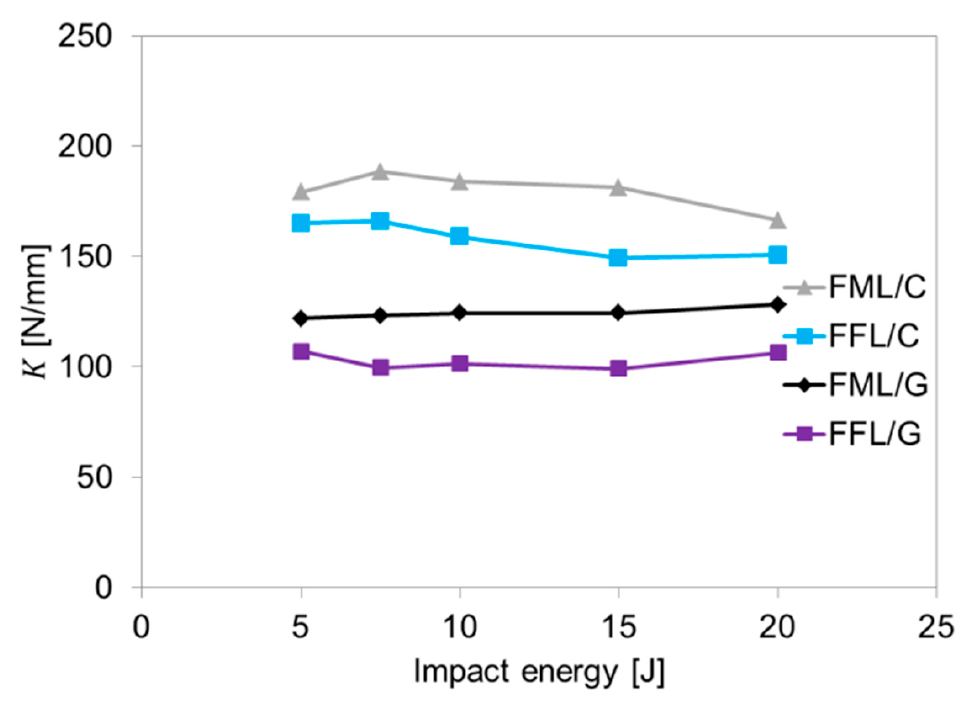
Figure 6. Bending stiffness of investigated laminates under various impact energies. The analysis of the results shows that using foam layer instead of metal layer causes a significant decrease in bending stiffness of the laminates. The K in general is independent on the impact energy, but it is a feature of a laminate (when keeping comparable: thickness, geometry and boundary conditions of the bending test). However, the K parameter can be used for comparison between conventional fibre metal laminates and laminates with foam. The average value of the bending stiffness for FFL/C laminates is 157.9 N/mm (standard deviation, SD 6.9 N/mm) and it is 13.9% lower in relation to FML/C laminates (179.7 N/mm, SD 8.3 N/mm). In the case of FML/G, K is on average 124.3 N/mm (SD 2.4 N/mm), which is over 17.4% higher than FFL/G (102.7 N/mm, SD 3.7 N/mm). Moreover, this difference may be a result of the lower proportion of metal layers in fibre foam metal laminates [42]. Literature data show that foam sandwich structures exhibit higher bending stiffness, but that is in the case of conventional, thicker and rigid foams like PVC [23]. The used polyethylene foam is elastic, which was important for the simultaneous compression and infiltration by a composite matrix. Nonetheless, it should be noted that the bending stiffness differences between FML and FFL correspond with results from force–displacement curves where it was observed that fibre foam metal laminates were characterized by greater deflection than fibre metal laminates (see Figure 4) reaching higher energies and hence more energy. Consequently, a greater deflection of the laminate is possible, which causes a greater stress concentration in the impact region, and higher delamination due to shear between the layers